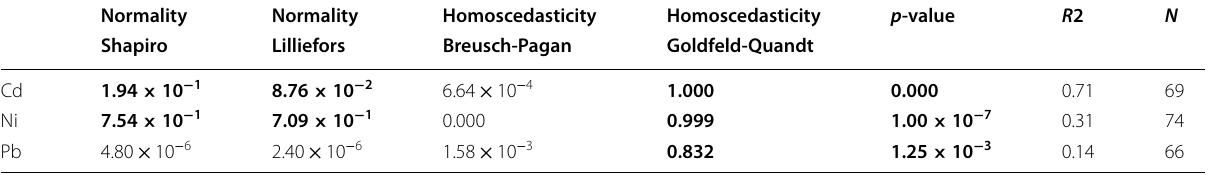
Significant results are indicated in bold text